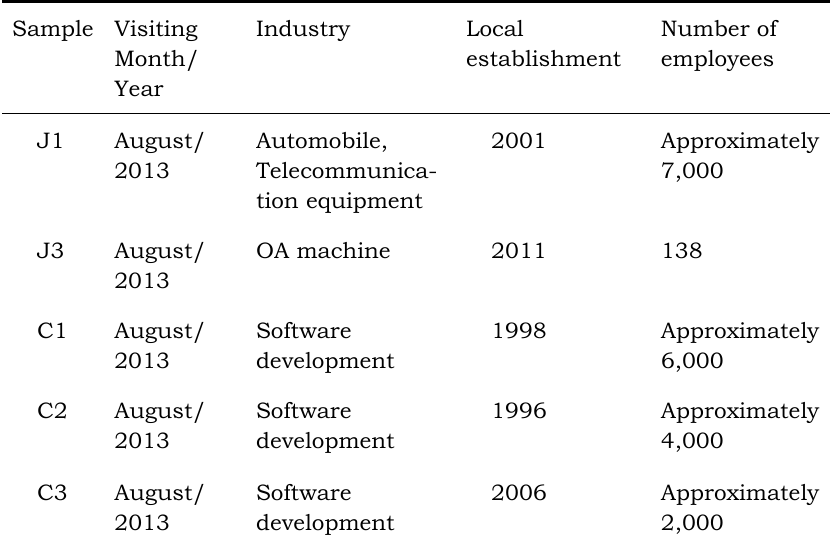
Table 1. Interview sample